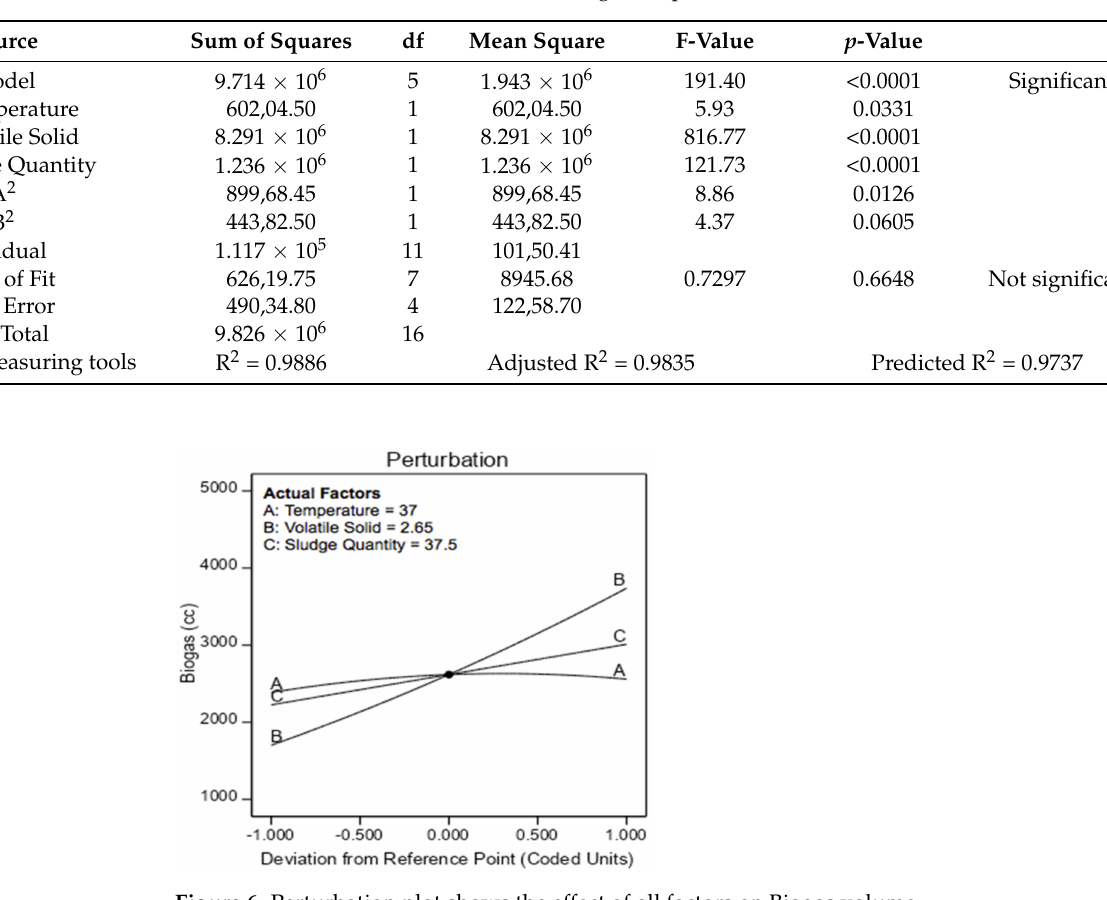
Figure 6. Perturbation plot shows the effect of all factors on Biogas